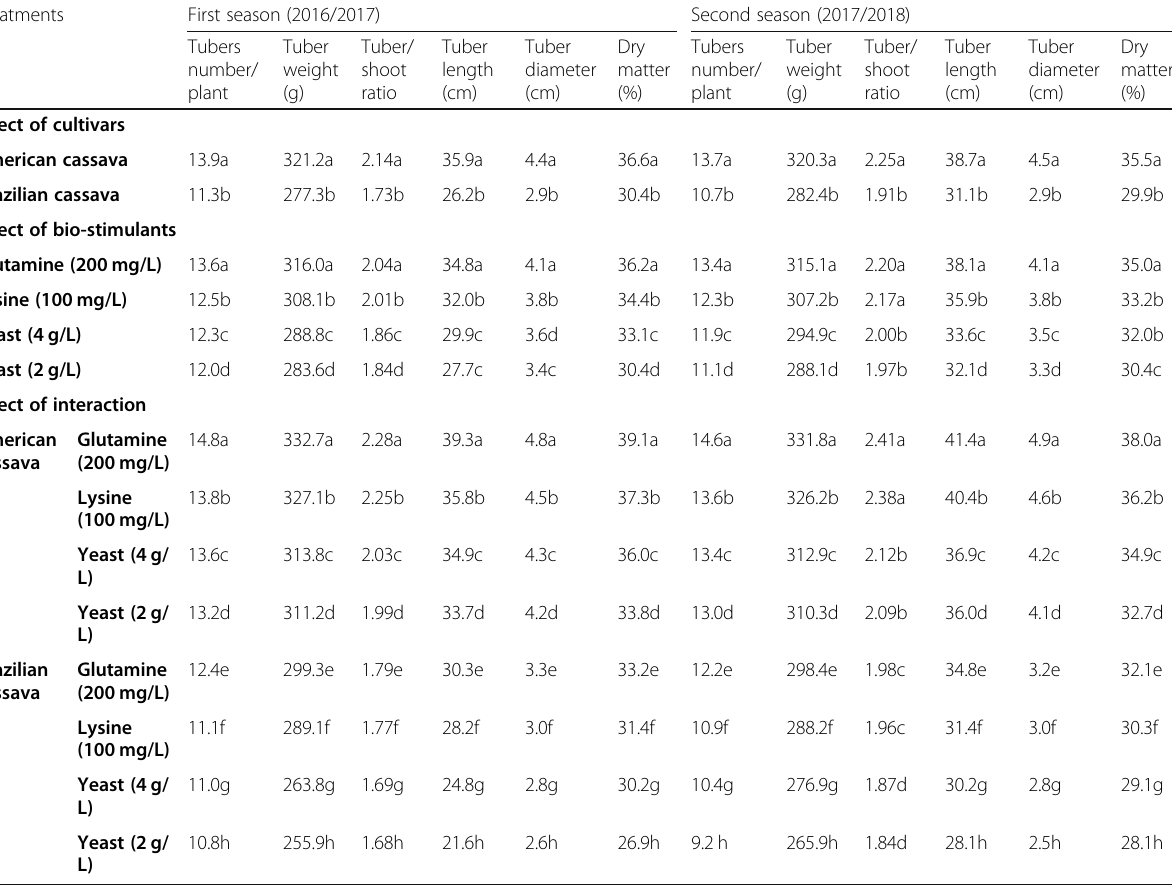
Table 2 Effect of different bio-stimulants on tuber yield and tuber characters of Cassava cultivars in 2016/2017 and 2017/2018 seasons Treatments